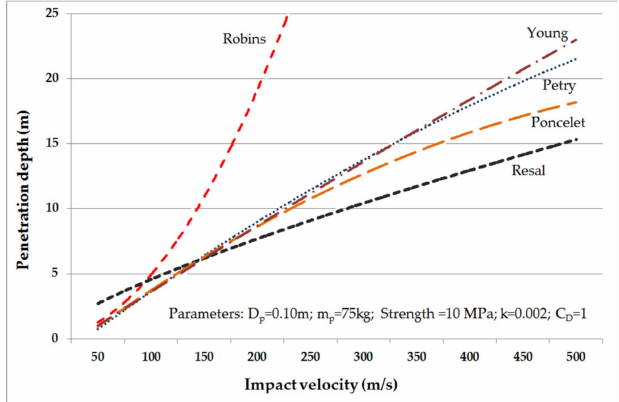
Figure 8. Comparison of penetration depth using the di ff erent methods.